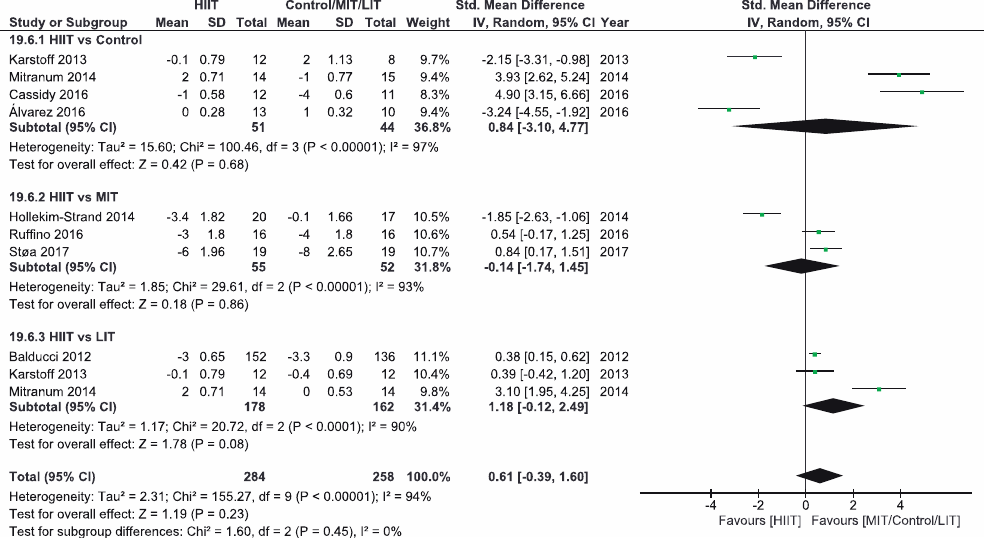
Figure 5. Forest plot for diastolic BP. HIIT—high-intensity interval training, MIT—moderate-intensity training, LIT—low-intensity training, CI—confidence interval, IV—inverse variance, SD—standard deviation.